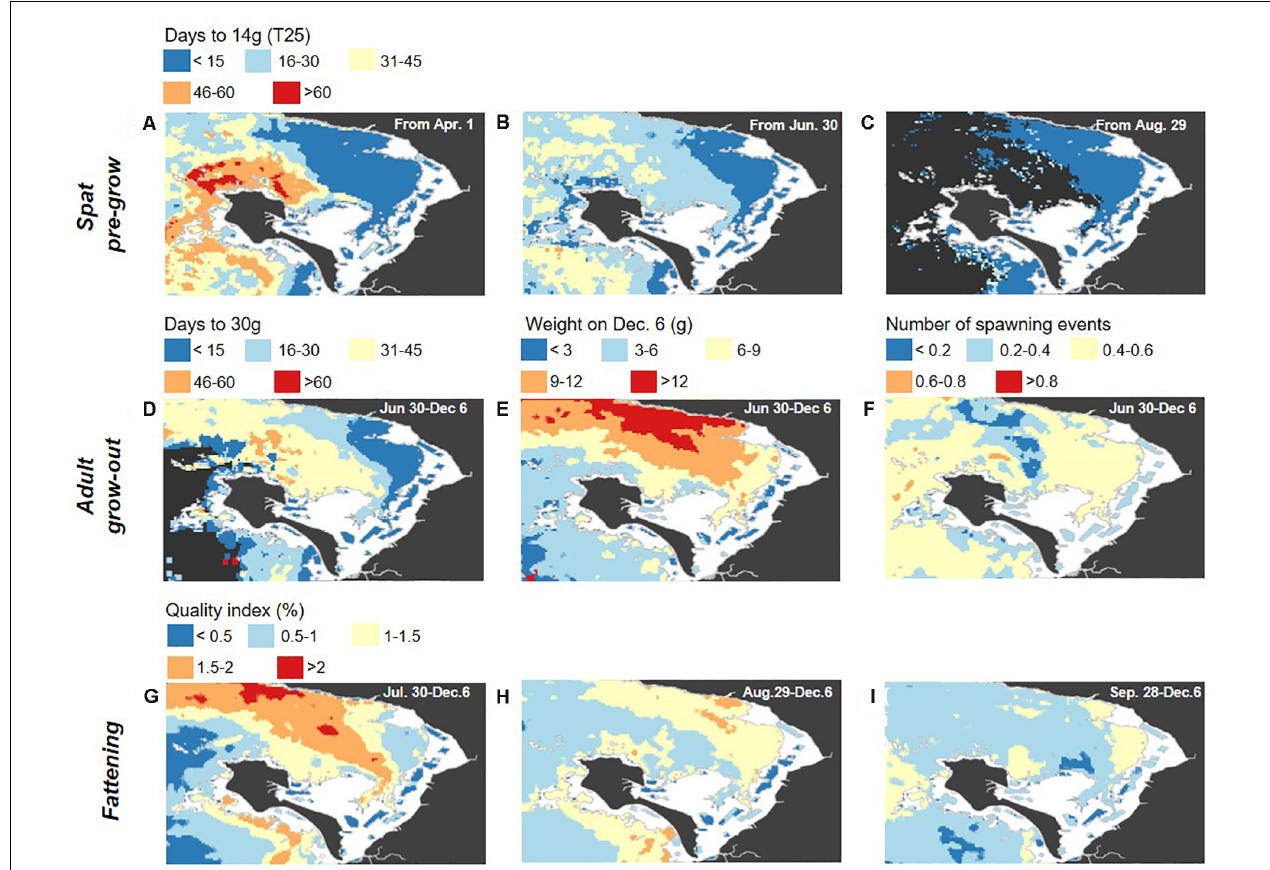
FIGURE 8 | Maps of the nine-year interannual standard deviations for the scenarios and growth indicators detailed in Table 3 , for the spat pre-growing phase (A–C) , from an initial T6–T8 (0.5 g) size, adult grow-out phase (D–F) , from an initial T25 (14 g) size, and final fattening phase (G–I) , from an initial Caliber 3 Normale size (76 g; QI = 6%). These correspond to the means presented in Figure 7 . Note that dark gray water areas in (A–D) correspond to areas where the target weight (i.e., 14 g for spat and 30 g for adults) was not achieved by the end of the growing